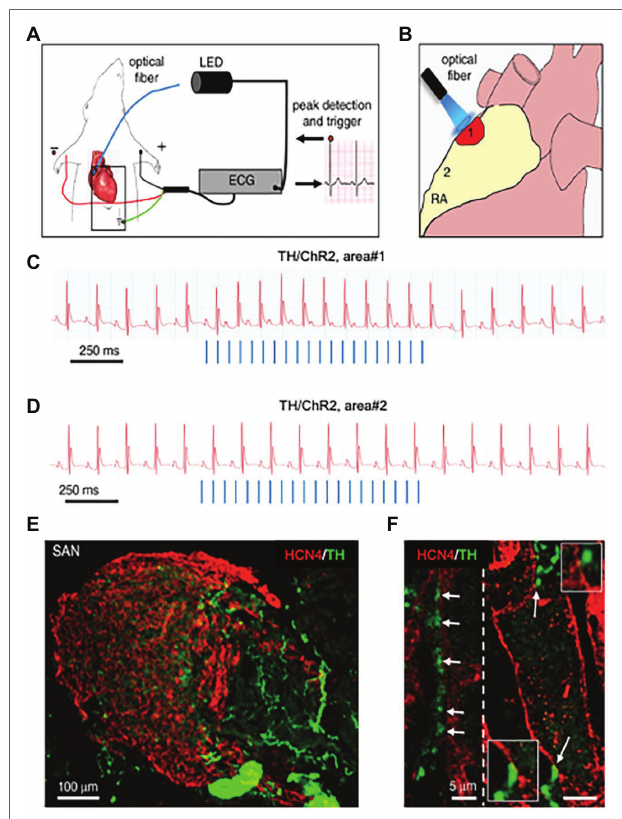
FIGURE 7 | Optogenetic control of cardiac sympathetic neurons in vivo . (A) Schematic illustration of the neuronal optogenetic set up used for right atrium illumination in open-chest anaesthetized mice. (B) Representation of the different photostimulated atrial regions (areas#1–2). (C) Representative ECG trace of the optogenetic experiment, showing positive chronotropic response upon photoactivation (blue lines) of the right atrial area#1 in TH/ ChannelRhodopsin2 (TH/ChR2) mice. (D) Representative trace showing unchanged HR upon illumination of area#2. Behavior of experiments (C,D) was observed in n = 15 mice. (E,F) , area#1 was analyzed with double immunofluorescence with SAN (HCN4) and SN (TH) markers. The magnified image (F) highlights the close interaction between SN varicosities and SAN myocytes (left) and an example of multiple neuronal processes interacting with the same myocyte (right). Modified with permission from Prando et al.